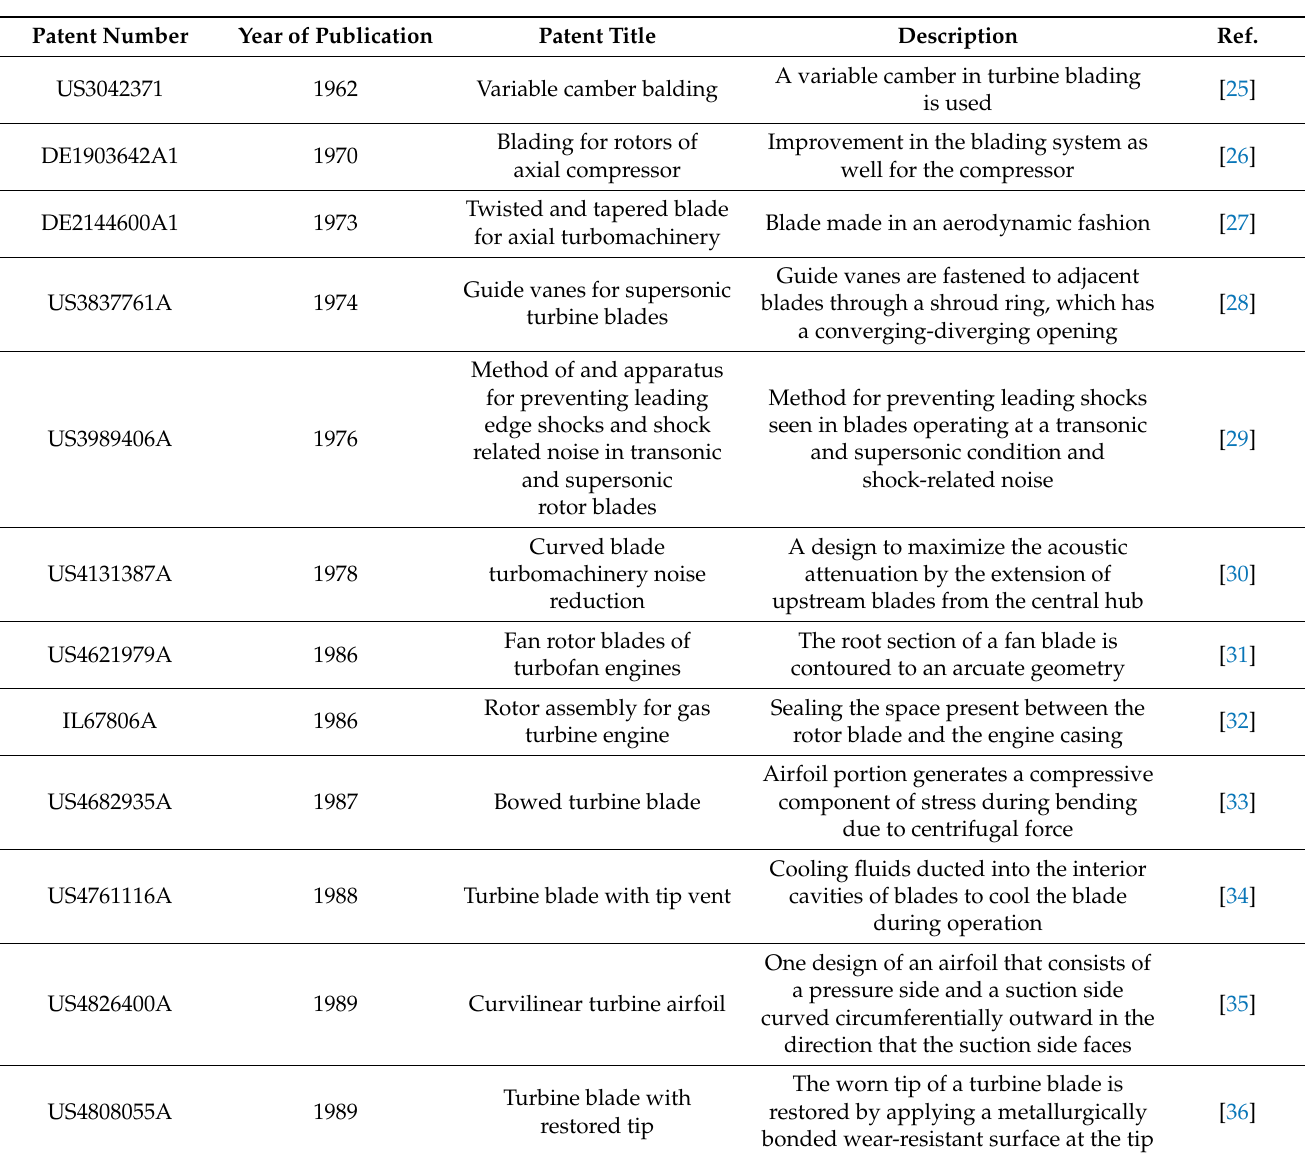
Figure 4. Design of ( a ) film cooling and ( b ) cooling by effusion [24]. Table 1. Evolution of turbine blade design.